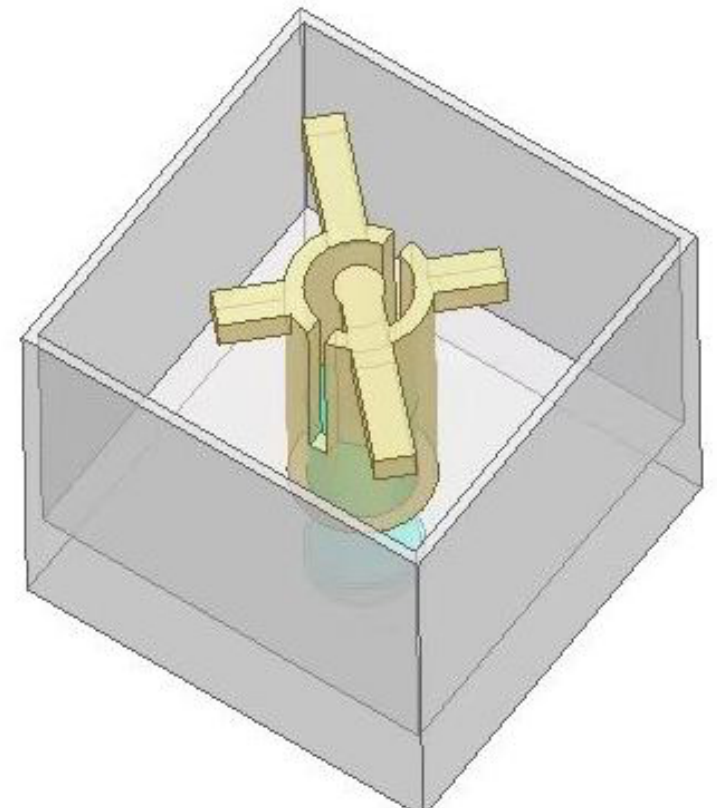
Figure 4. Design diagram of the antenna element.